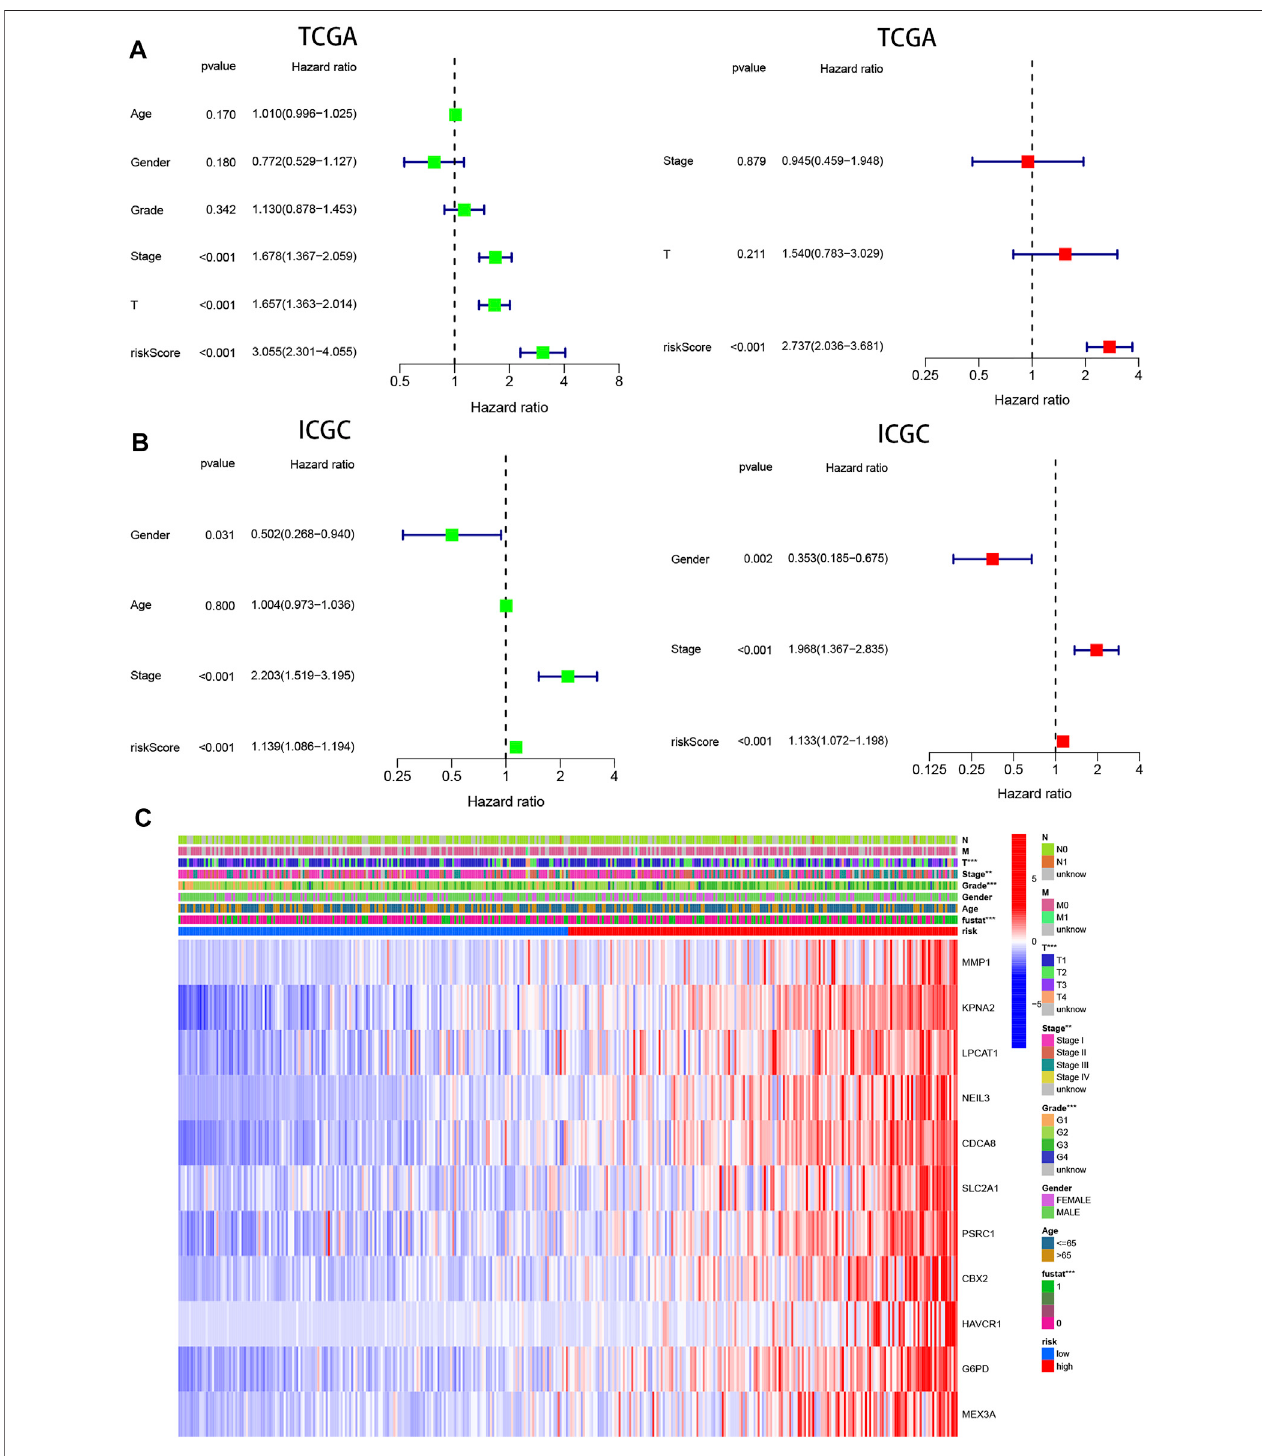
FIGURE6| PrognosticvalueofthepyroptosisrisksignatureinHCC. (A,B) UnivariateandmultivariateCoxanalysesevaluatingtheindependentprognosticvalueof the pyroptosis signature in terms of OS in HCC patients in TCGA and ICGC cohorts. (C) Heatmap showing the relationship between clinicopathological characteristics and different risk groups. ** p < 0.01, and *** p < 0.001.